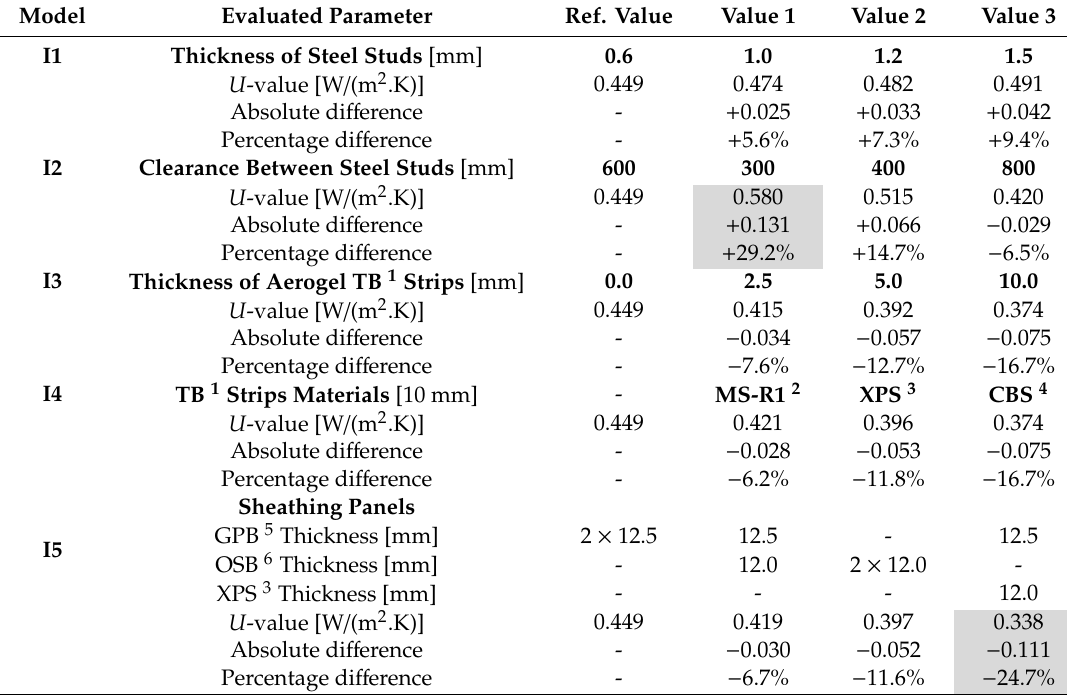
Table 8. Thermal transmittance obtained for interior LSF partition walls.